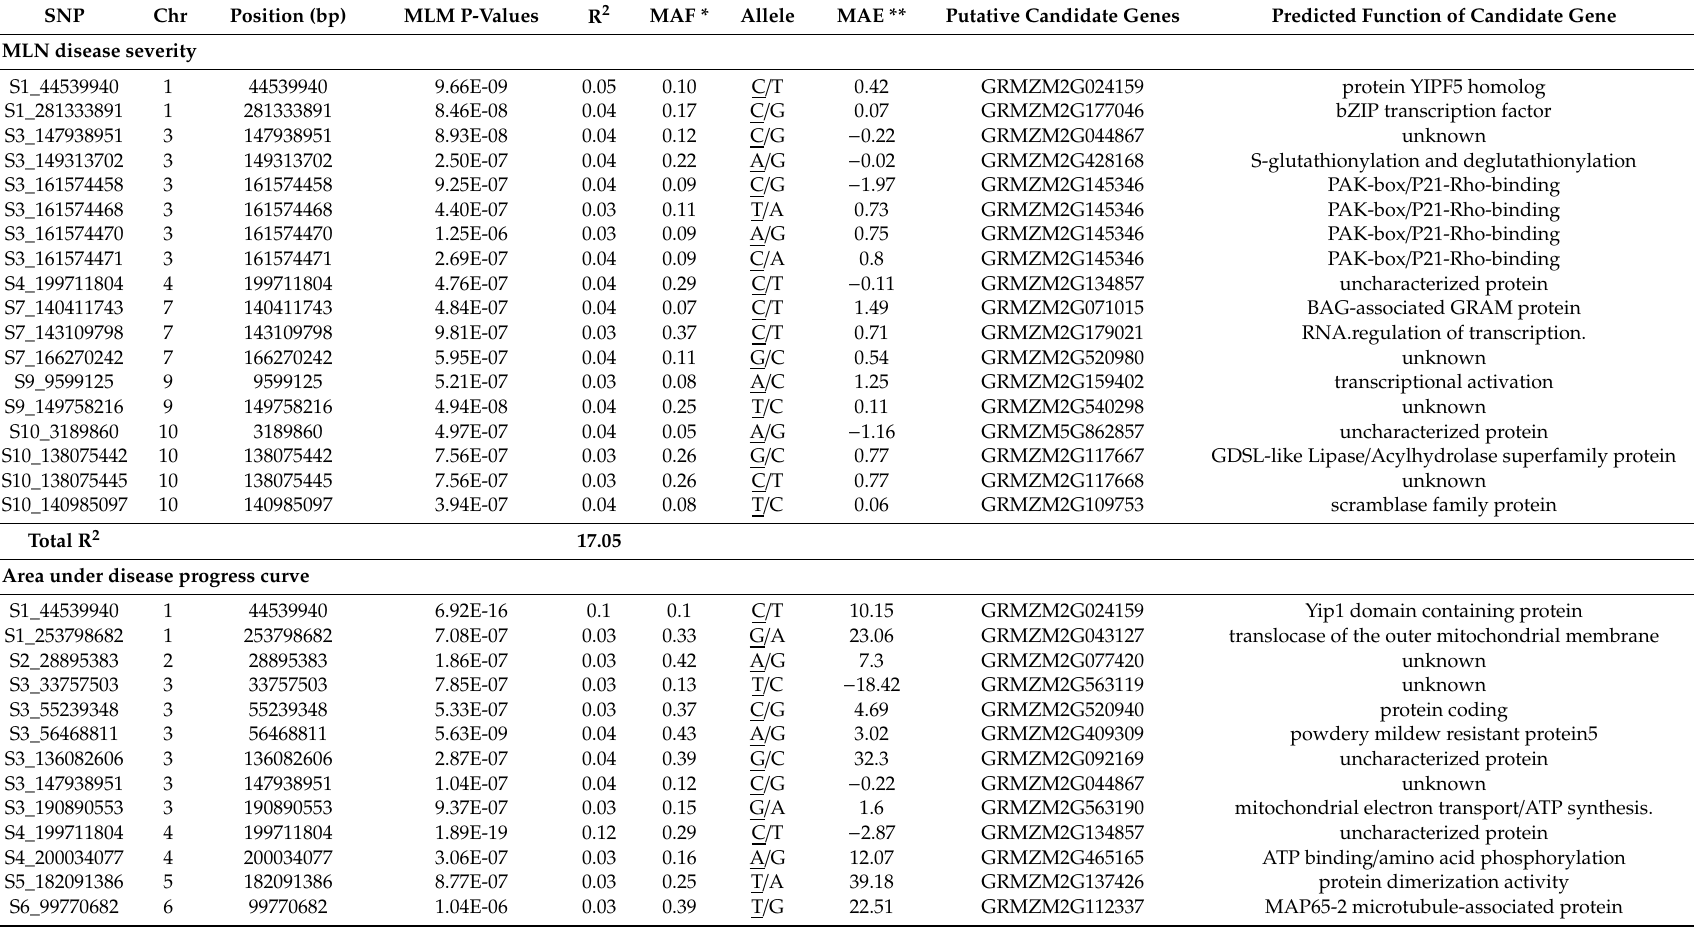
Table 2. Details of the MLN resistance associated SNP markers and their probable candidate genes identified in the large set of association mapping